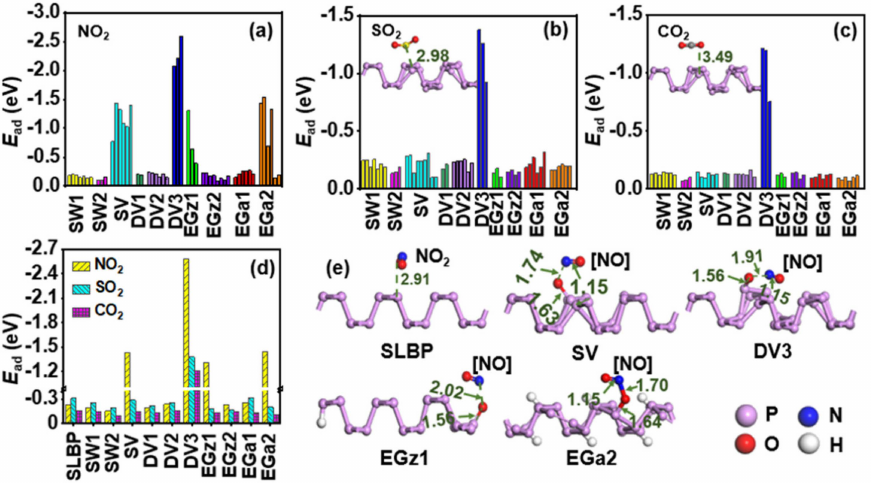
Figure 2. Adsorption energies ( E ad , eV) computed for stable adsorption configurations of NO 2 ( a ), SO 2 ( b ) or CO 2 ( c ) on different adsorption sites of d − SLBP. E ad values of the most stable adsorption configurations ( d ). The most stable adsorption configurations of NO 2 on SLBP, SV, DV3, EGz1 and EGa2 ( e